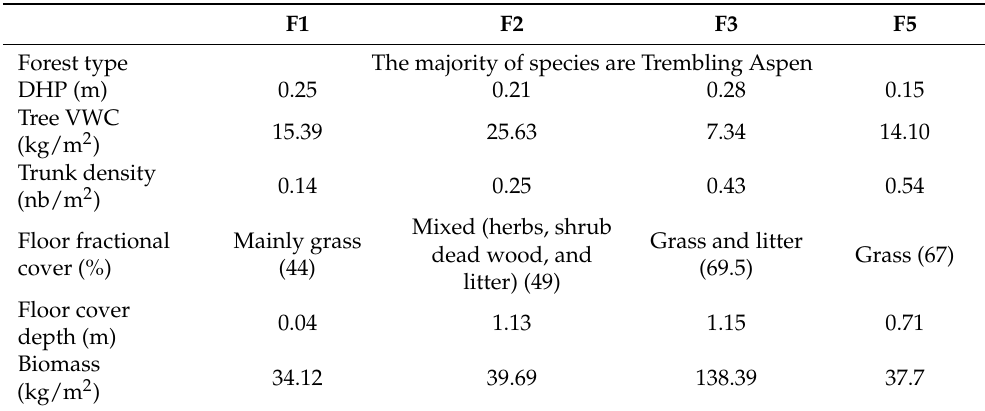
Table 3. Characteristics of forested